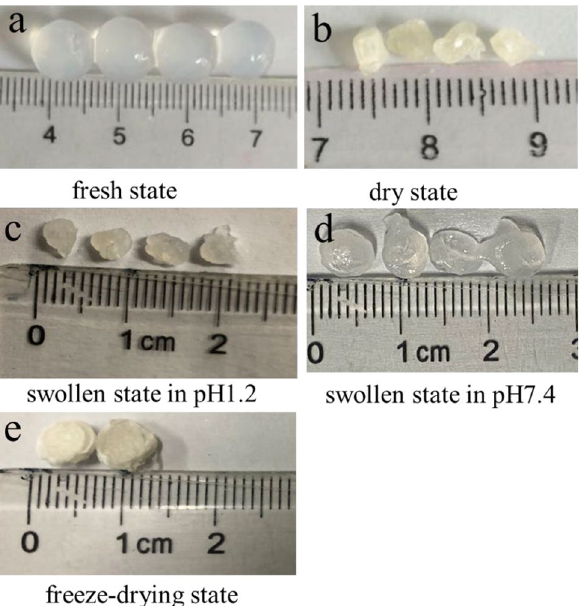
Figure 4. The morphologies of SA-CMC@PDMA-1 hydrogels in different state. [( a ) in fresh state; ( b ) in dried state; ( c ) in swollen state at pH1.2; ( d ) in swollen state at pH 7.4; ( e ) in freeze-drying